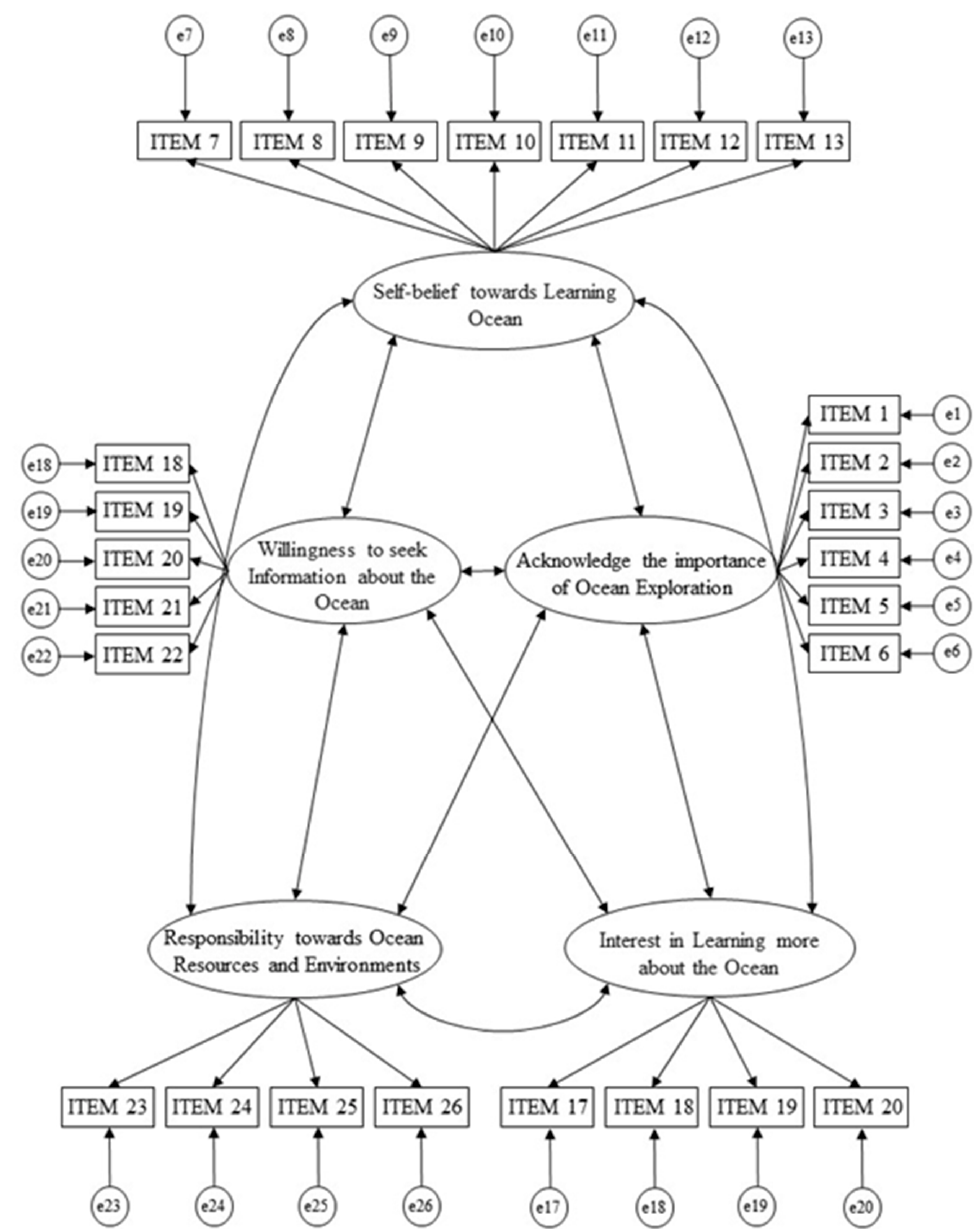
Figure 1. The CFA-hypothesized model of the AOI on